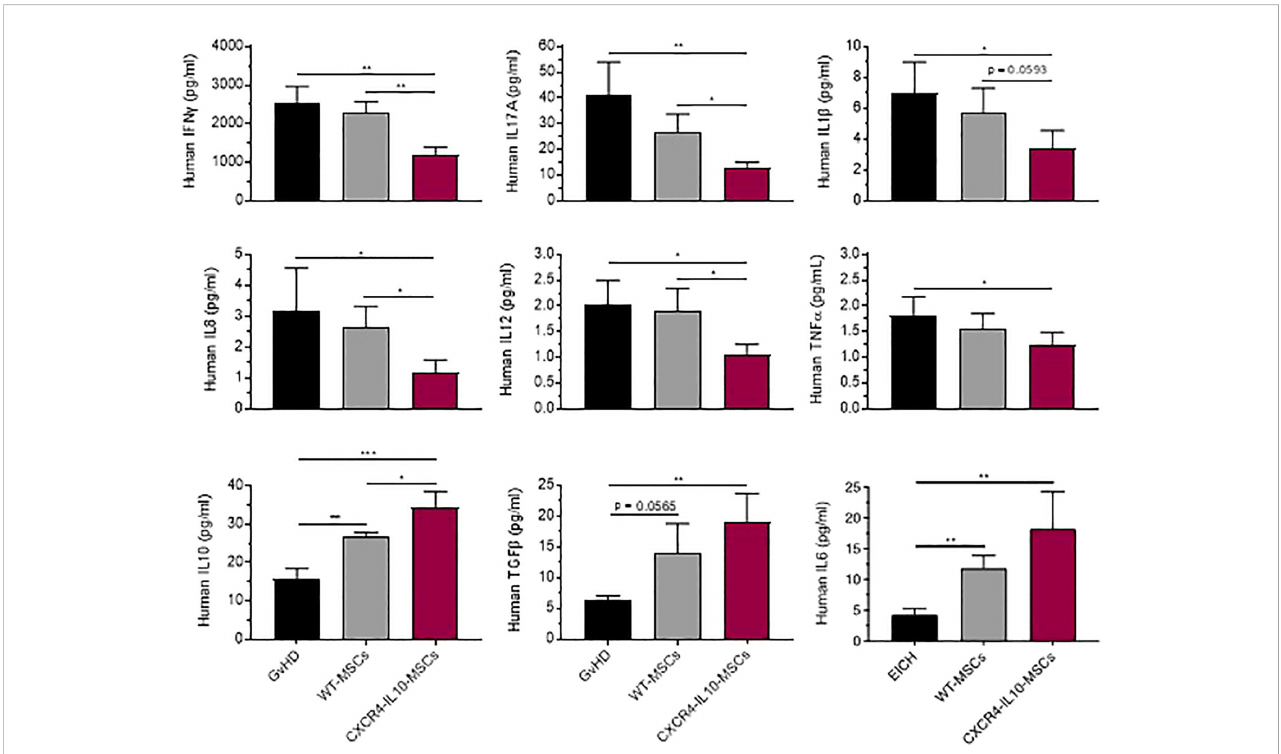
FIGURE 5 Enhanced changes of immunomodulatory pro fi le in the serum of GvHD recipients treated with CXCR4-IL10-MSCs. Analysis of cytokine and factor levels in the serum of NSG recipients treated with WT- or CXCR4-IL10-MSCs. Analyses were conducted three weeks after NSG mice transplantation. Each bar represents the mean ± SEM of data from 9-12 mice per group. *p < 0.05; **p < 0. 01; ***p <